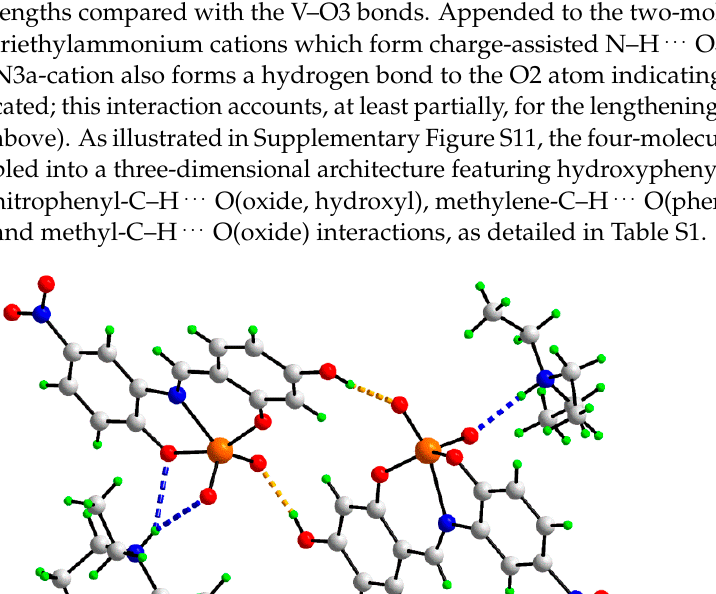
Table 2. Geometric parameters (Å, °) characterizing the identified hydrogen bonding contacts between the constituents of the asymmetric unit of salt 1 leading to a four-molecule aggregate.